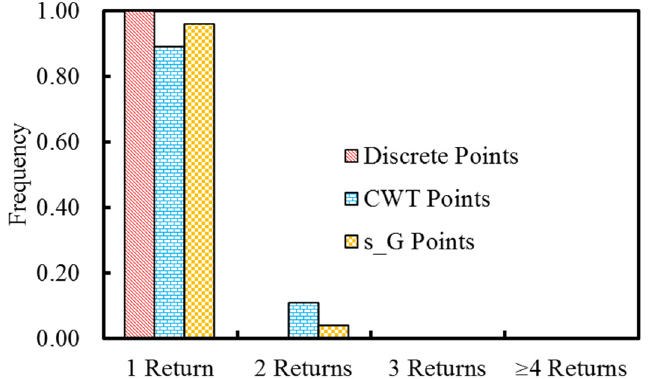
Figure 11. Distribution of the number of full waveform returns for different peak detection methods on the Blue/Colorado River. CWT and s_G methods are better able to detect multiple returns while almost all discrete points are single